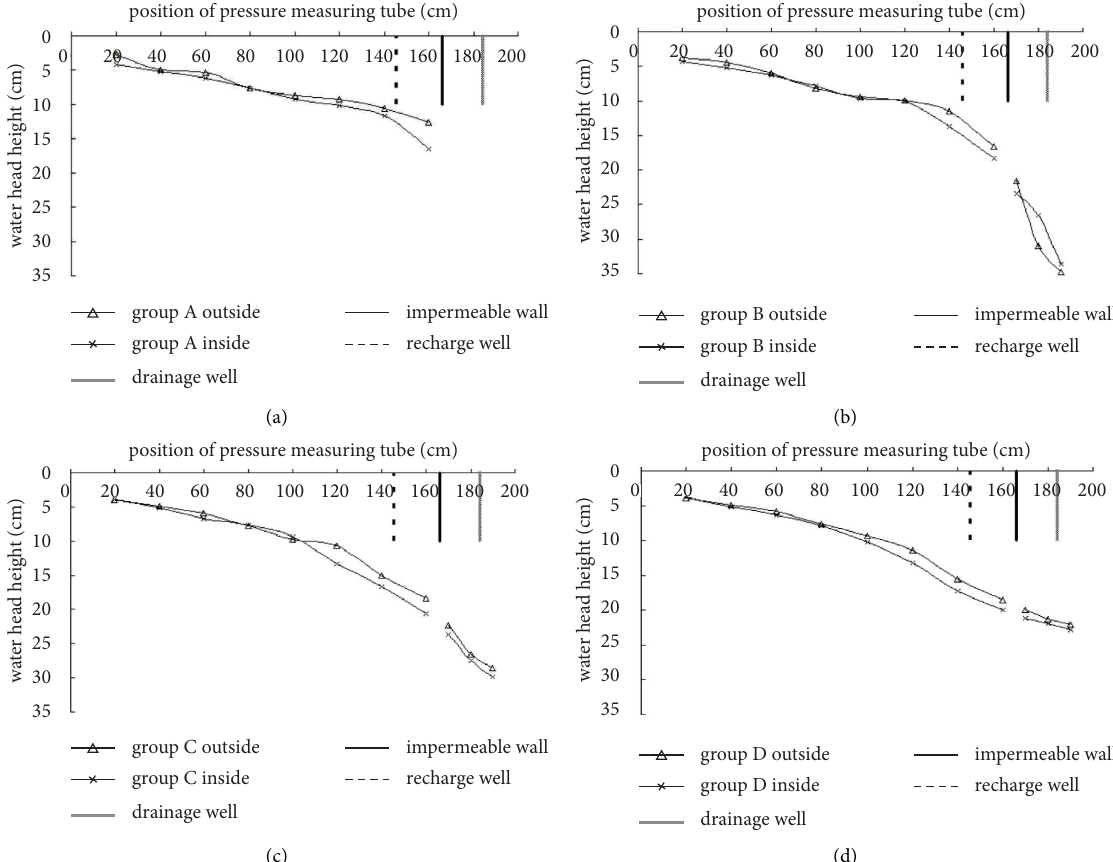
Figure 6: Te variation laws on the water level during dewatering-seepage control-recharge coupling. (a) Variations in the heads inside and outside the pressure measuring tubes in row A with distance under recharging. (b) Variations in the heads inside and outside the pressure measuring tubes in row B with distance under recharging. (c) Variations in the heads inside and outside the pressure measuring tubes in row C with distance under recharging. (d) Variations in the heads inside and outside the pressure measuring tubes in row D with distance under recharging.